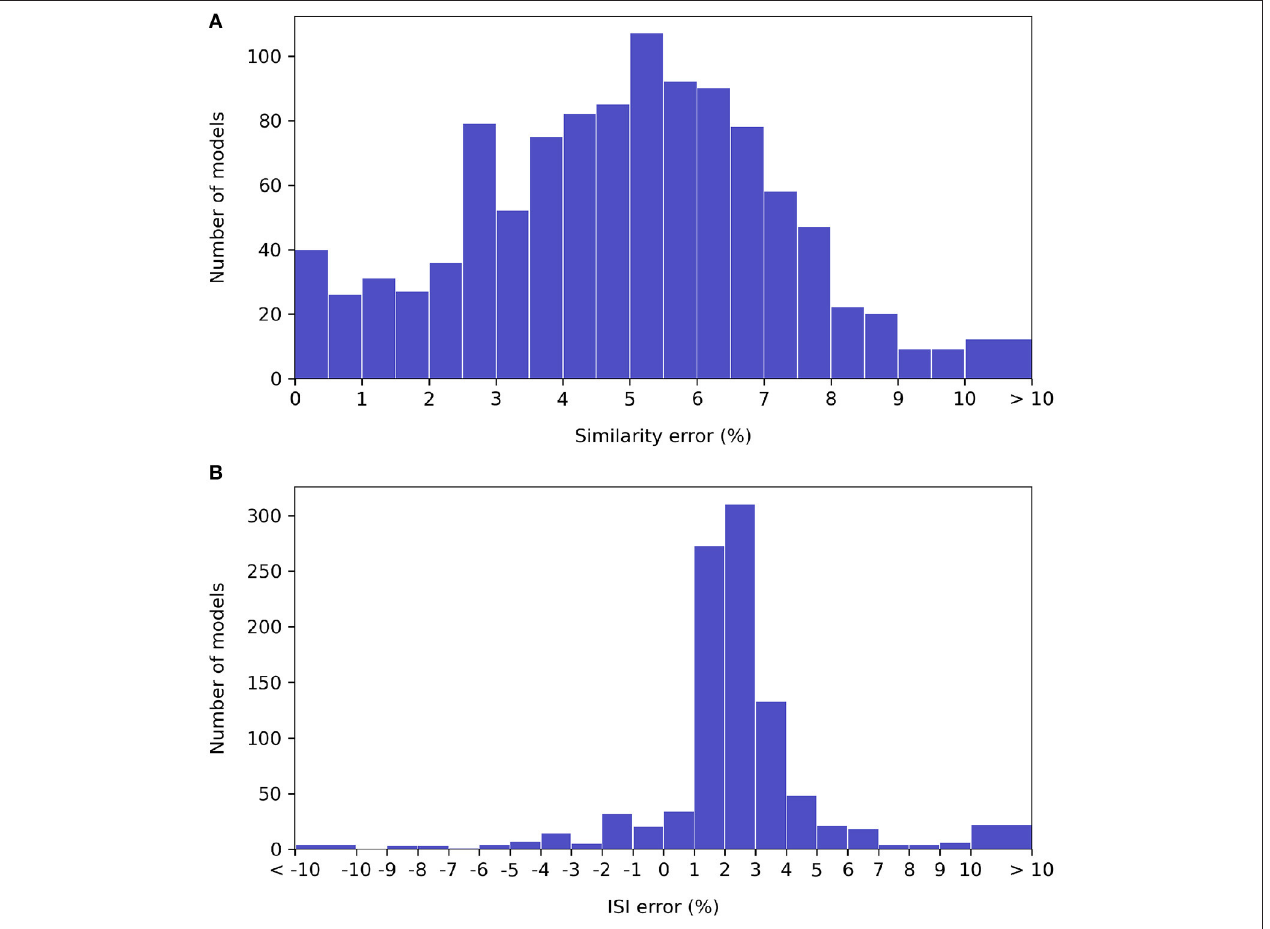
FIGURE 7 | Histograms of relative error under the NeuroML-DB similarity (A) and inter-spike interval (B) accuracy metrics for each NeuroML-DB neuron model. The bins around the “<-10” and “>10” limits include all models with more than 10% of discrepancy.